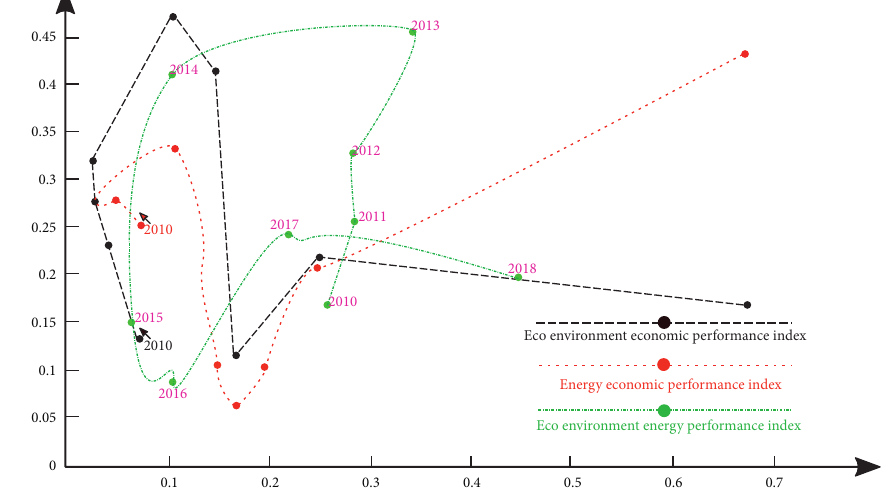
Figure 10: Relative changes of performance